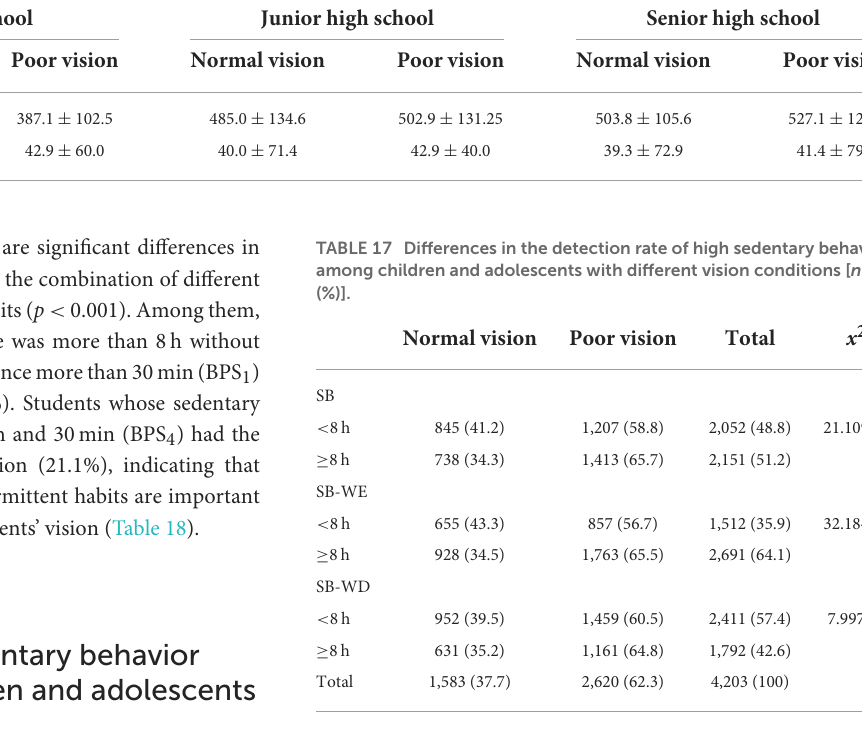
TABLE 16 Comparison of sedentary types of students with different visual acuity conditions in different grades.